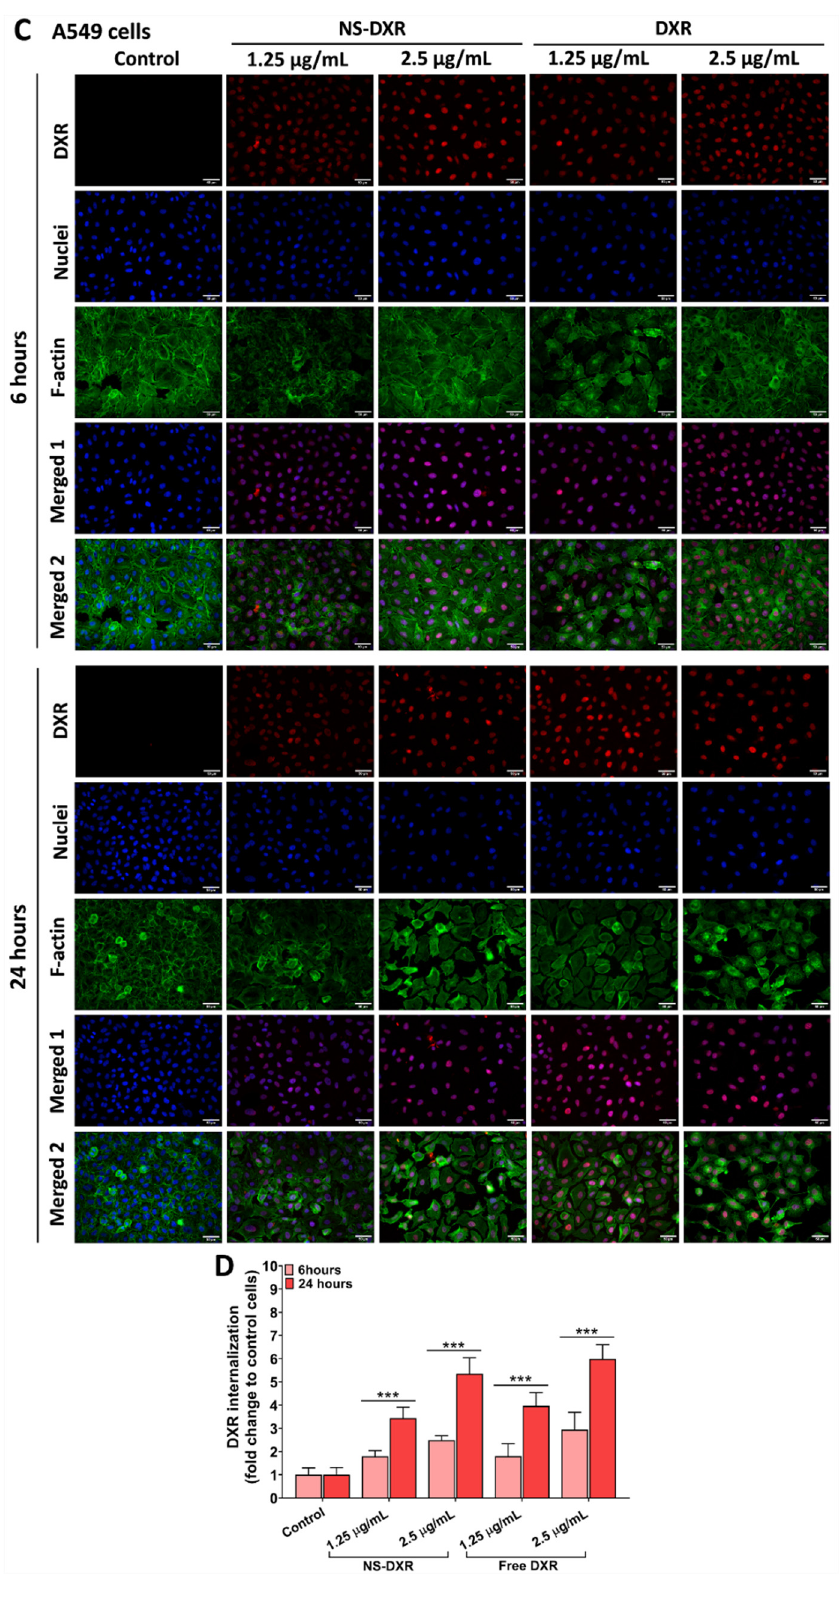
Figure 4. DXR fluorescence visualized in HepG2 ( A ) and A549 cells ( C ) incubated with NS-DXR and free DXR for 6 and 24 h. Cells were exposed to two doses of DXR either free or loaded into NS-DXR (1.25 and 2.5 μ g/mL). The nanoparticle concentrations corresponding to 1.25 and 2.5 μ g/mL of loaded DXR are 62.5 and 125 μ g/mL, respectively. Representative fluorescence microscopy images show the internalized DXR (red), nuclei stained by DAPI (blue) and F-actin, obtained by cell staining